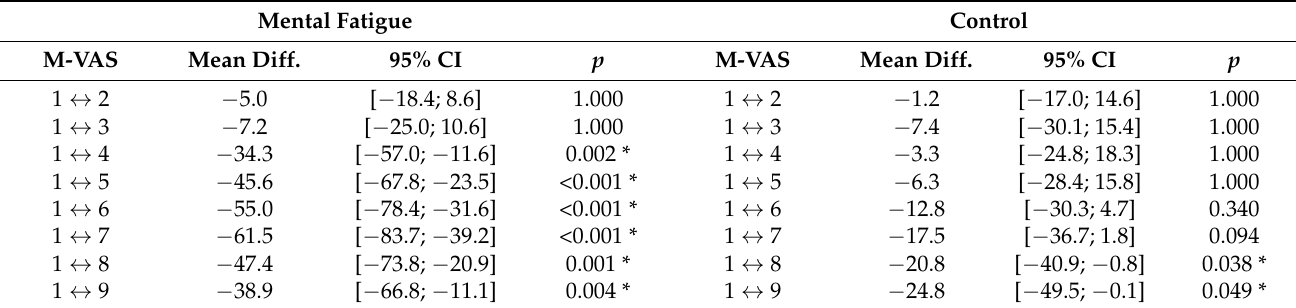
Table 3. Effect of time on the M-VAS measurements in both conditions.